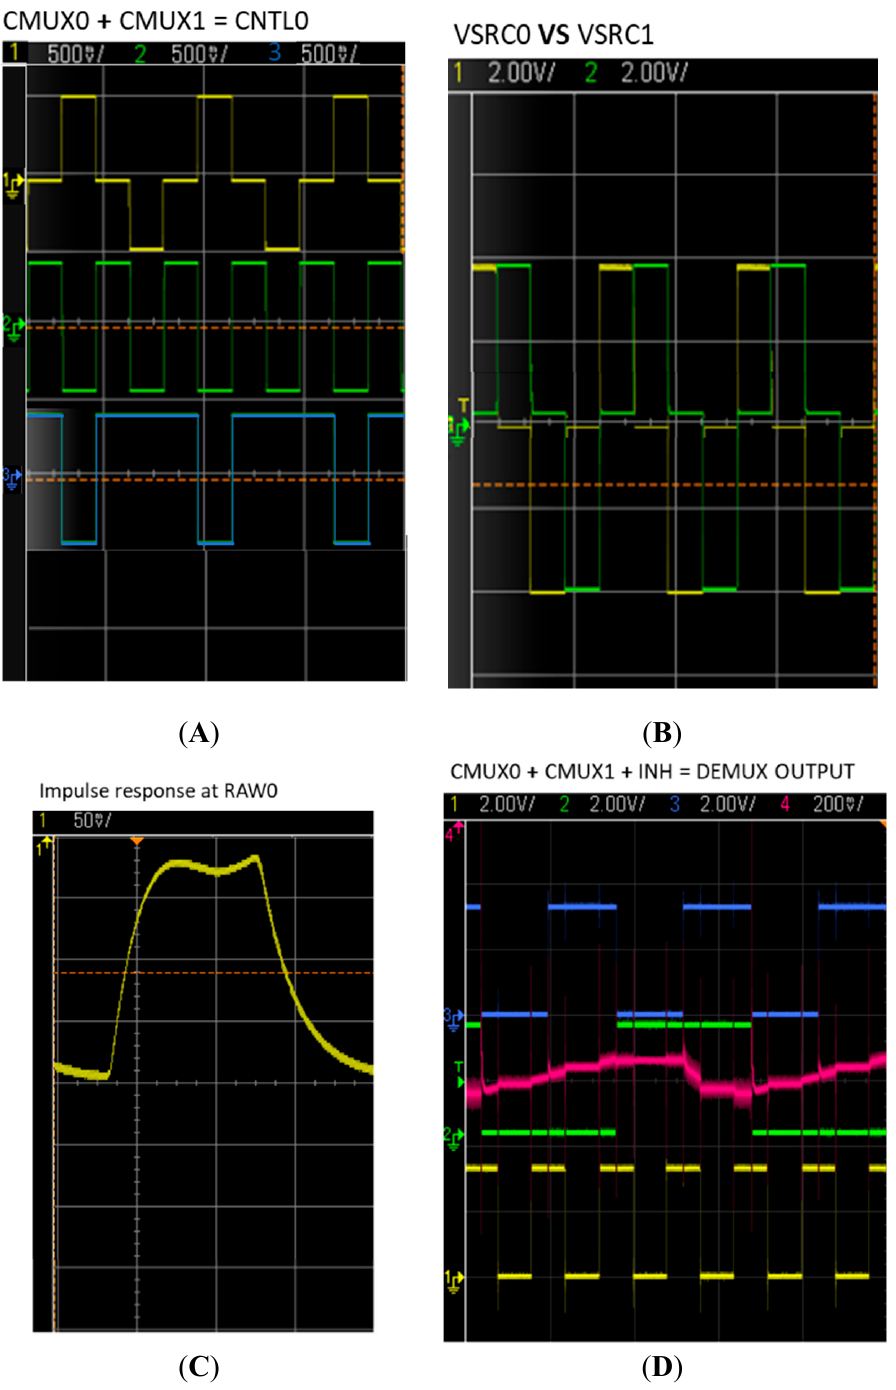
Figure 7. ZenTBI debug tests on the oscilloscope. ( A ) shows the outputs of the microcontroller CMUX0 in blue and CMUX1 in green. In accordance with the multiplexor’s truth table, CMUX0 and CMUX1 generate CNTL0, shown in yellow. ( B ) shows the output of the Howland pump circuits that control the LEDs’ currents. Two LEDs are controlled by the yellow pulses and other two by the green pulses. ( C ) shows the impulse response of a photodetector. ( D ) shows the demux controls generated by the microcontroller, CMUX0 as the green line, CMUX1 as the purple line, and the INHIBIT as the yellow line.